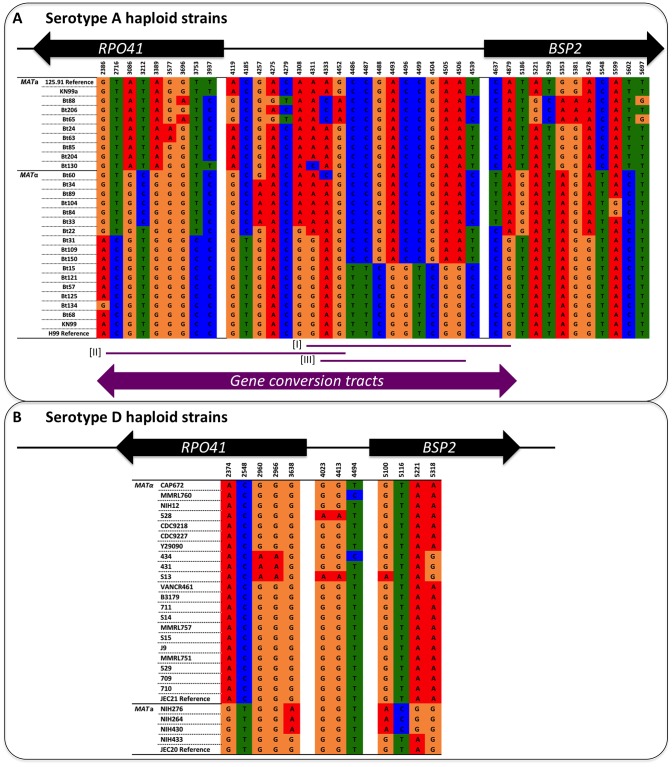
Illustration of polymorphic sites among serotype A and D haploid strains.The positions of the polymorphic sites are shown at the top, and they correspond to the distances of the sites from the 3′ end of the RPO41 gene (see also Figure 2). For simplicity, only parsimony informative sites are shown here. (A) Serotype A strains. Sites from 2386 to 3937 are located within the RPO41 gene, sites from 4119 to 4539 are located within the intergenic region, while sites from 4637 to 5697 are located within the BSP2 gene. The purple lines and arrow at the bottom indicate locations and lengths of gene conversion tracts detected by GENECONV software. Examples of strain pairs from which the three gene conversion tracts were detected are: Bt22-Bt150 for tract [I], Bt109-Bt125 for tract [II], and Bt60-Bt31 for tract [III]. (B) Serotype D strains. Sites from 2374 to 3638 are located within the RPO41 gene, sites from 4023 to 4494 are located within the intergenic region, while sites from 5100 to 5318 are located within the BSP2 gene.